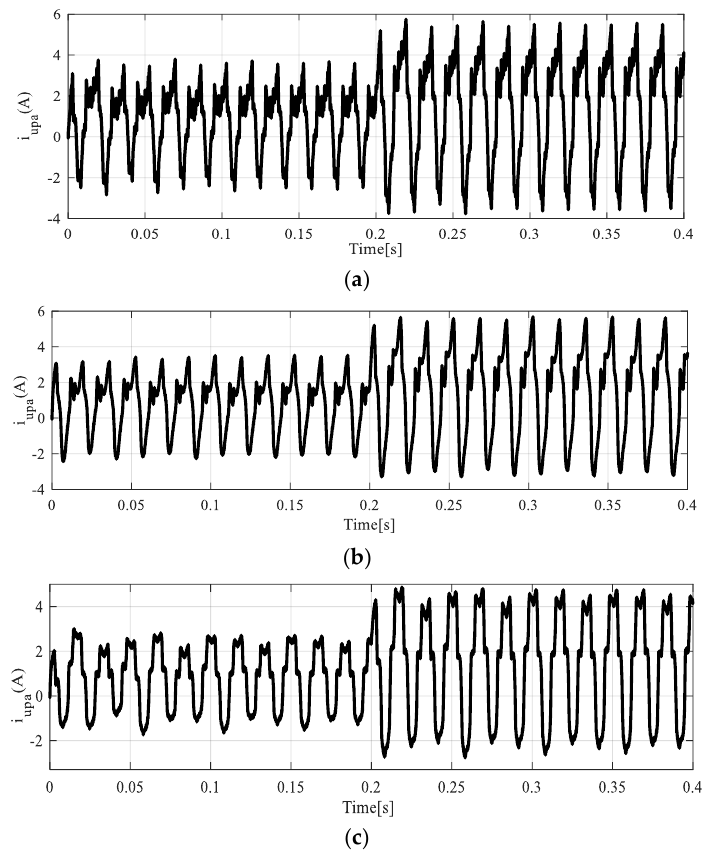
Figure 16. The upper arm currents of phase “a” for the ( a ) first controller, ( b ) second controller, and ( c ) third controller.